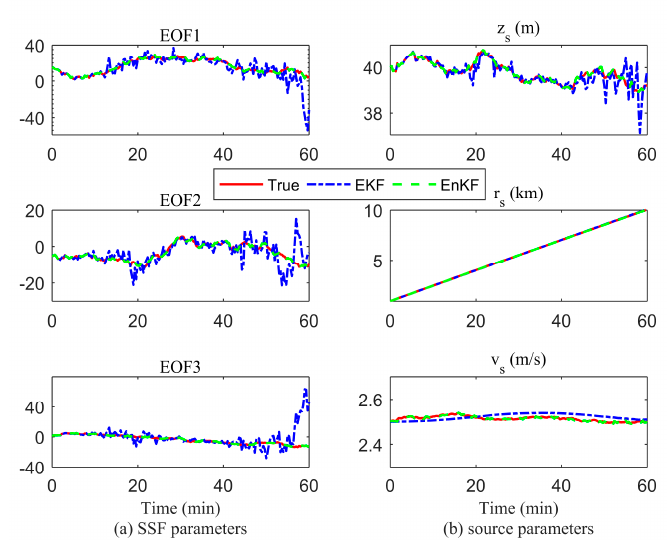
Figure 3. Joint time-evolving estimation results of the EKF (dash-dotted line) and EnKF (dashed line). The true values trajectories are in a solid line, ( a ) shows the first three EOFs’ coefficients; and ( b ) show the depth, range and speed of the source.